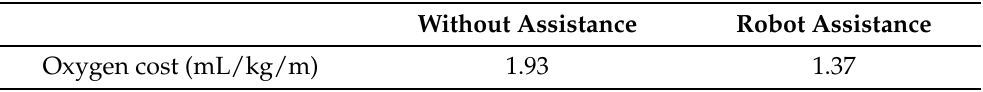
Table 5. Oxygen costs of the 6-min metabolic test of walking without assistance and walking with Angel Legs using bilateral